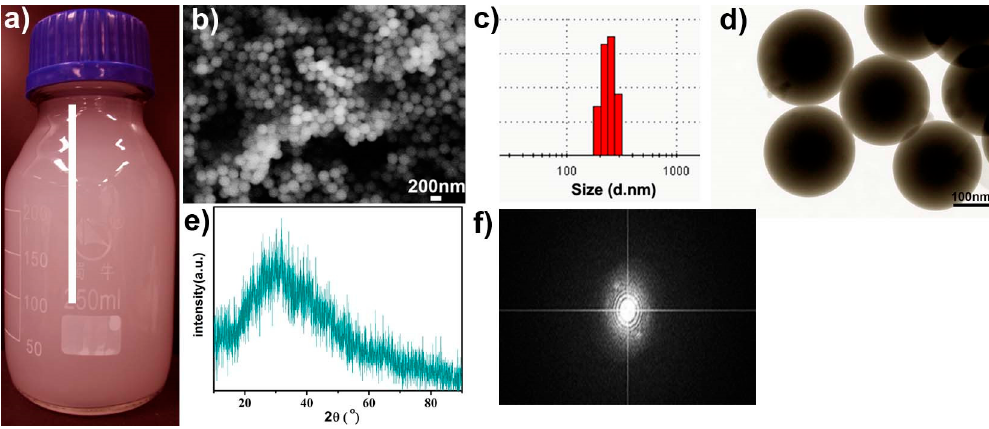
Figure 3. Photograph ( a ), scanning electron microscopy (SEM) ( b ), dynamic laser light scattering (DLS) ( c ) and transmission electron microscopy (TEM) ( d ) images, and X-ray diffraction (XRD) ( e ), and Fast Fourier Transformation (FFT) ( f ) images of the prepared DCAT nanospheres.